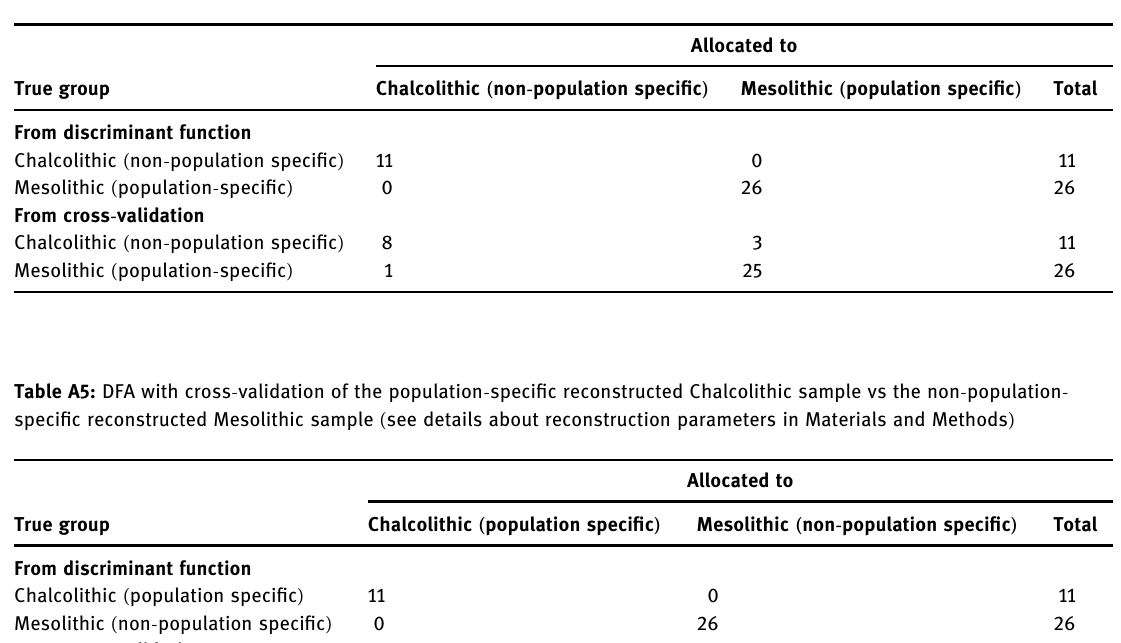
Table A4: DFA with cross - validation of the non - population - speci fi c reconstructed Chalcolithic sample vs the population - speci fi c reconstructed Mesolithic sample ( see details about reconstruction parameters in Materials and Methods )